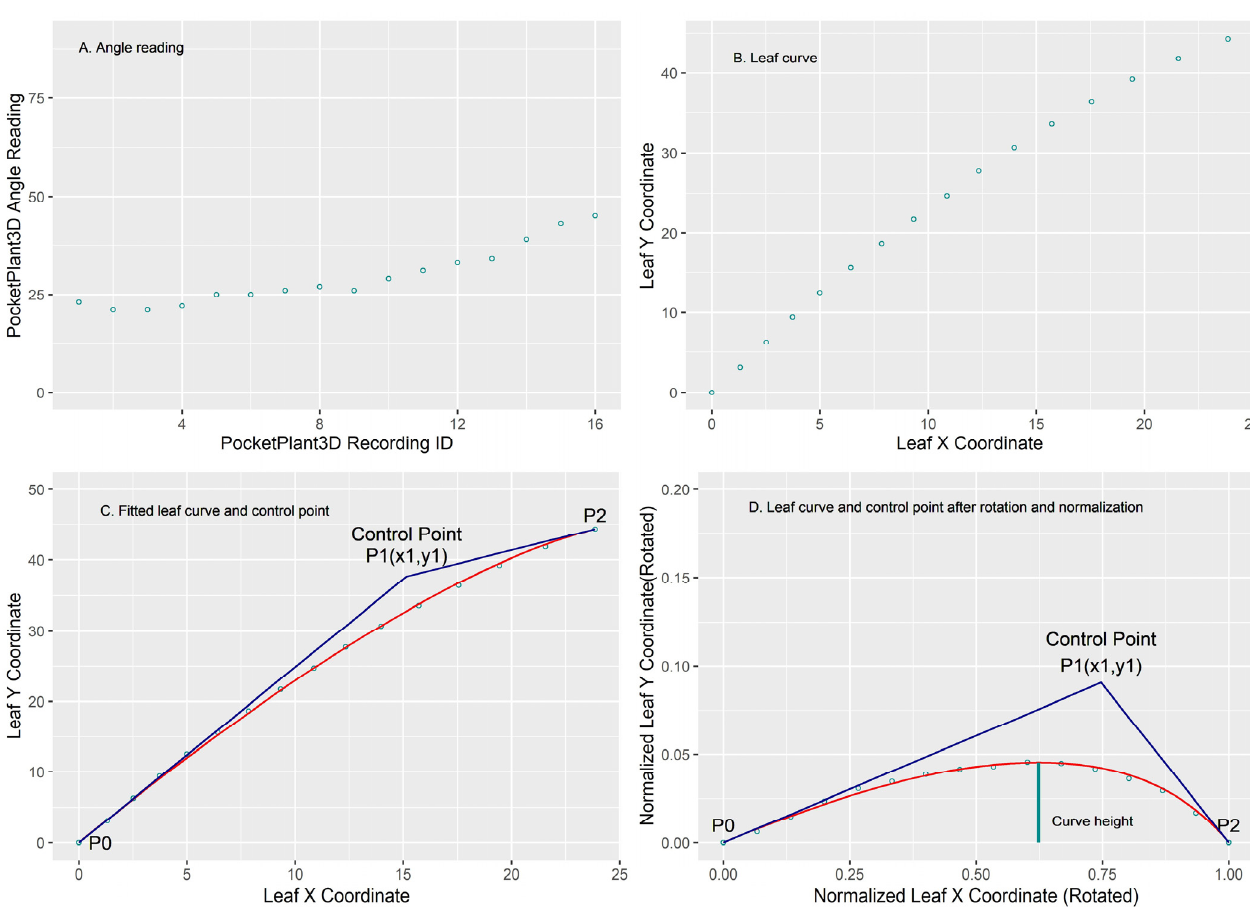
Figure 1. PocketPlant3D rice leaf angle readings and Bezier curve fitting. ( A ) PocketPlant3D leaf angle reading; ( B ) Leaf angle reading mapped to leaf x and y coordinates based on measured leaf length; ( C ) Bezier curve control point, observed (open circle) and fitted leaf curve (red line); ( D ) Bezier curve control point, observed (open circle) and fitted leaf curve (red line) after axis rotation and normalization.